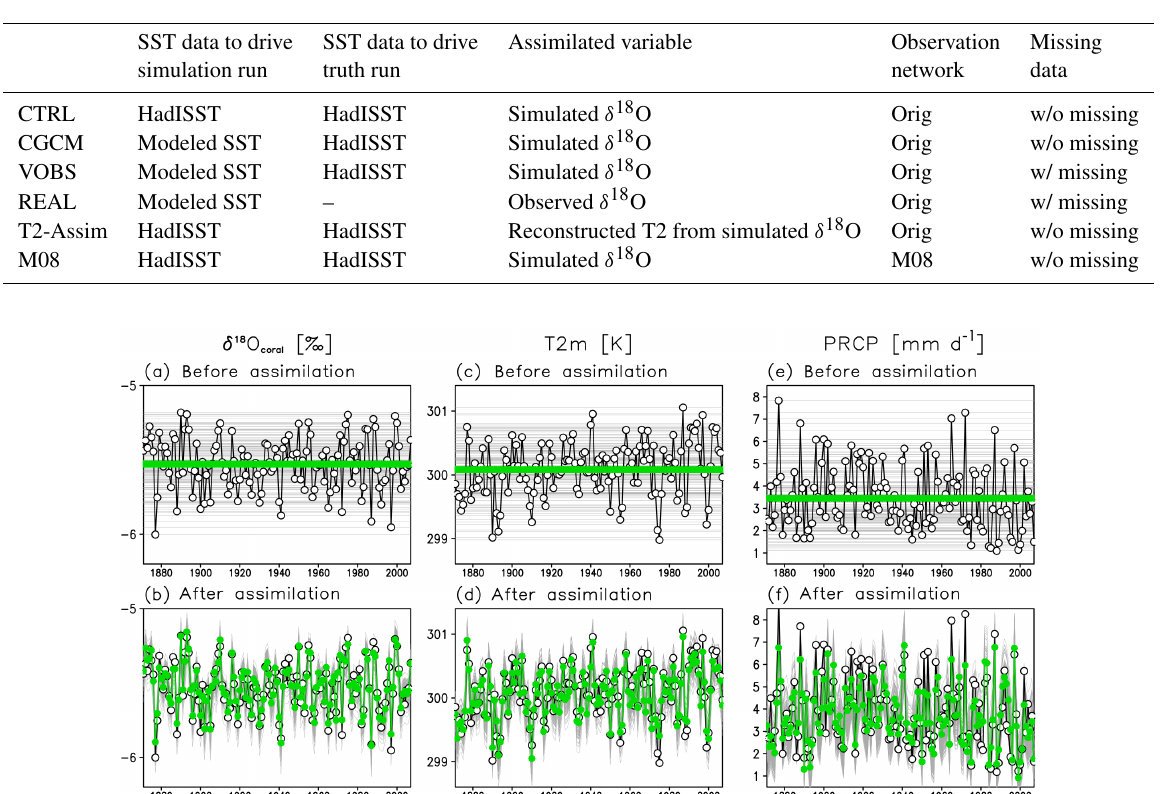
Table 1. Experimental designs. The observation network used in the CTRL experiment is denoted as Orig.